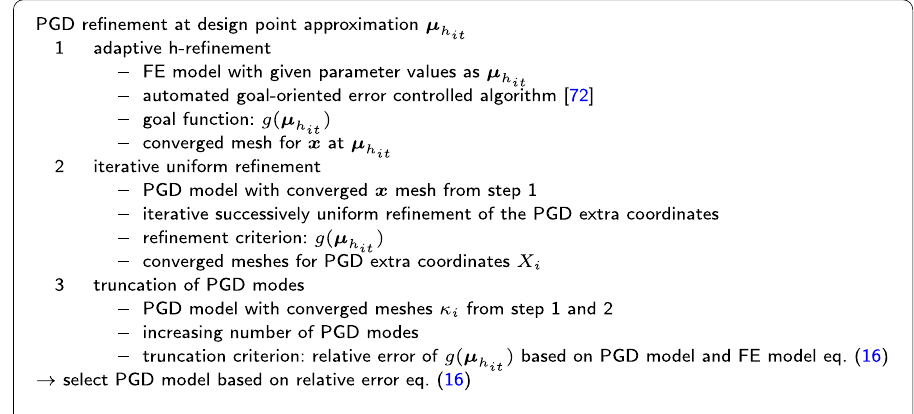
Fig. 4 PGD refinement ( itPGDrel-ref ): iterative refinement of the PGD solution (discretization and mode truncation) at the current μ h